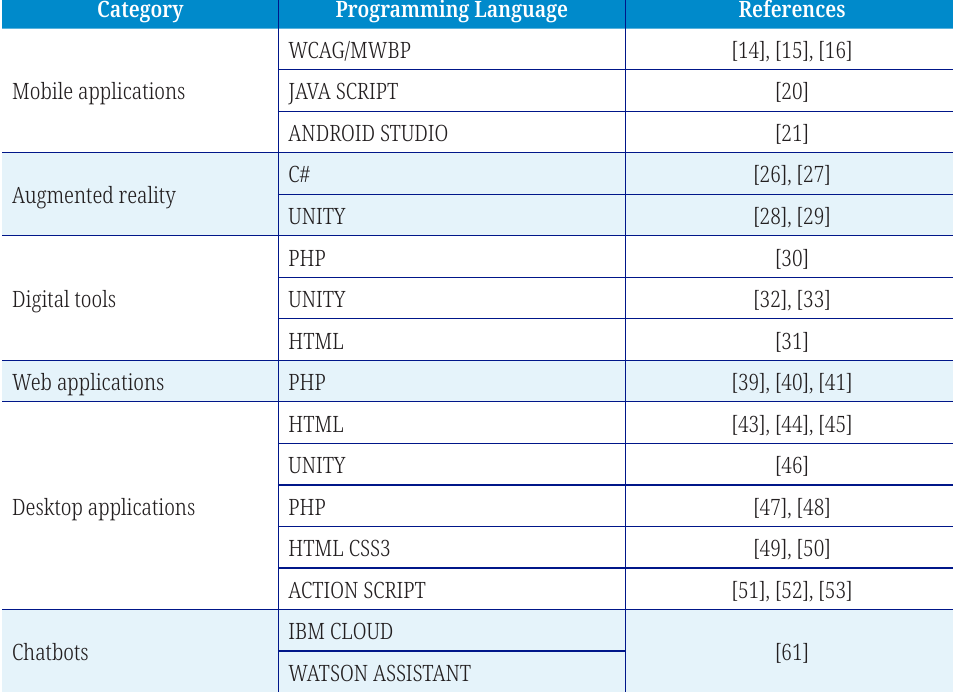
Table 4. Classification of articles according to category and programming language